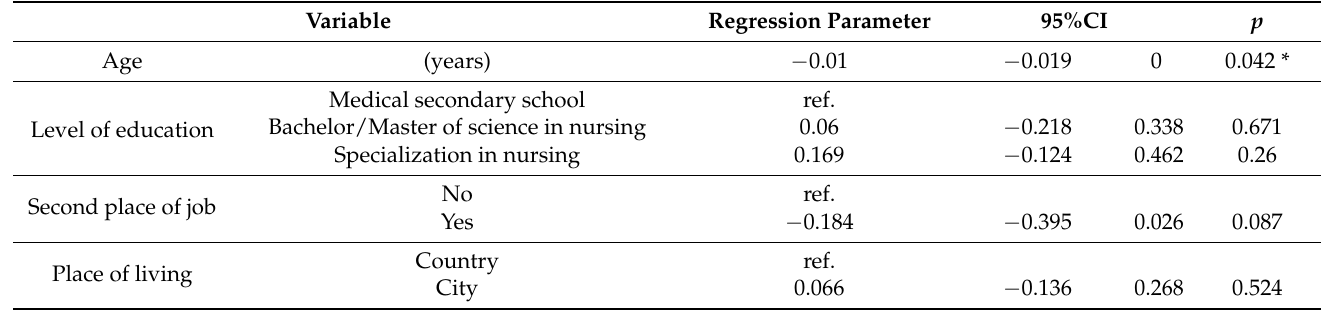
Table 7. BERNCA-R and sociodemographic variables—multifactorial